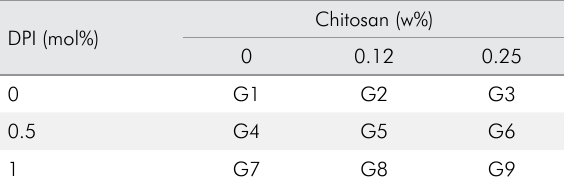
Table 1. Groups of experimental infiltrants according to composition in relation to diphenyliodonium salt (DPI) and chitosan